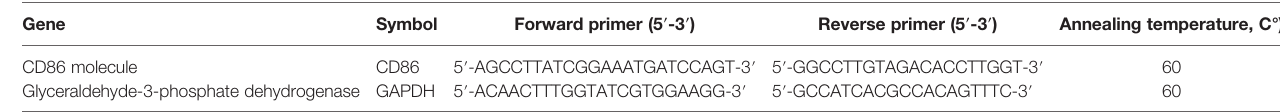
TABLE 1 | List of primers for